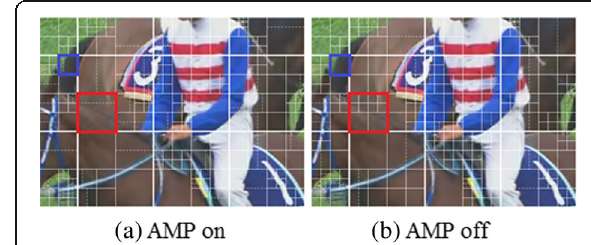
Table 3 Posterior probabilities of CU cur mode selection and